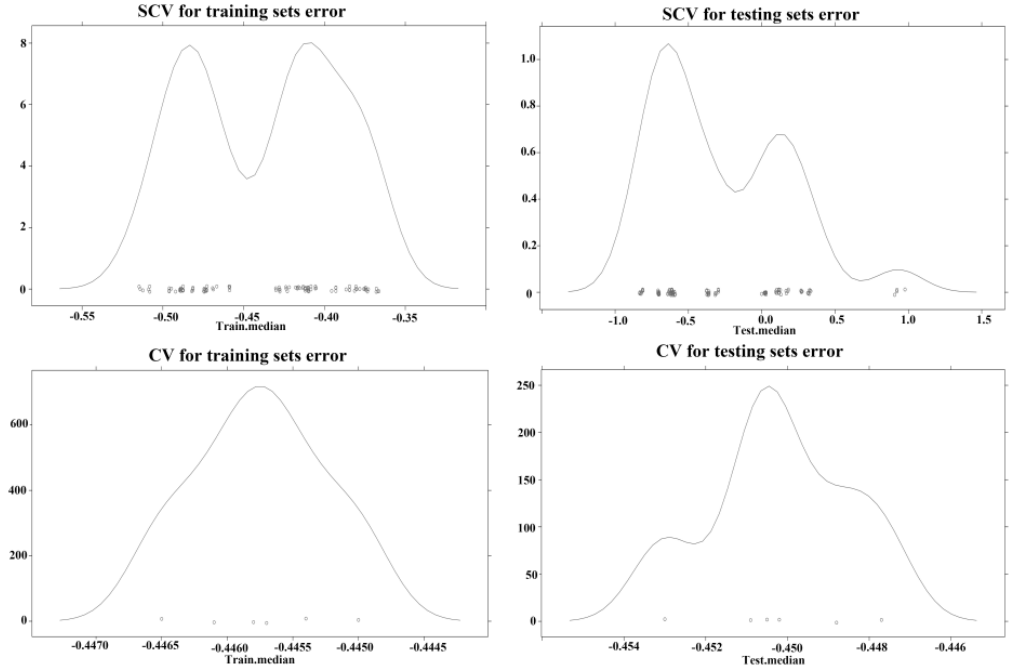
Figure 8. Kernel density plot for prediction error produced by SCV and CV. The small circles represent each data subset created from bootstrap.